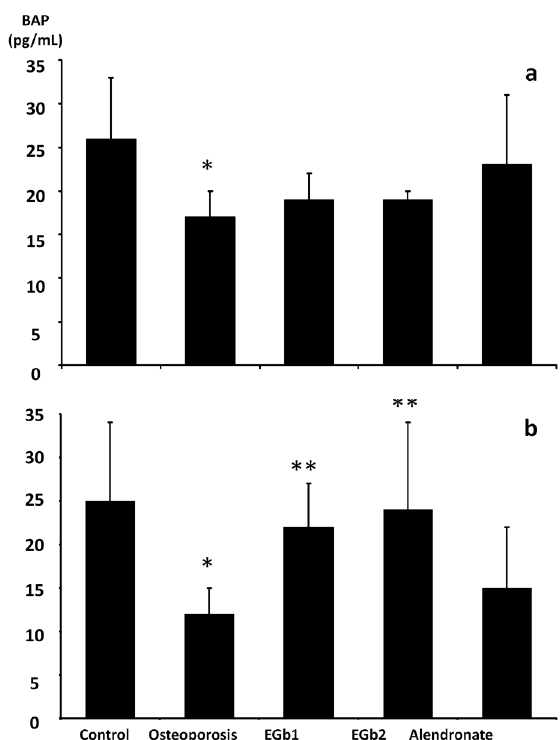
Figure 1 - The levels of bone alkaline phosphatase (BAP). a - 20 days of treatment. b - 30 days of treatment. *p<0.05 when the control group was compared to the osteoporosis group (Student`s t-test). **p<0.05 when all groups, except the control, were compared to the osteoporosis group (Dunnett T3 test).